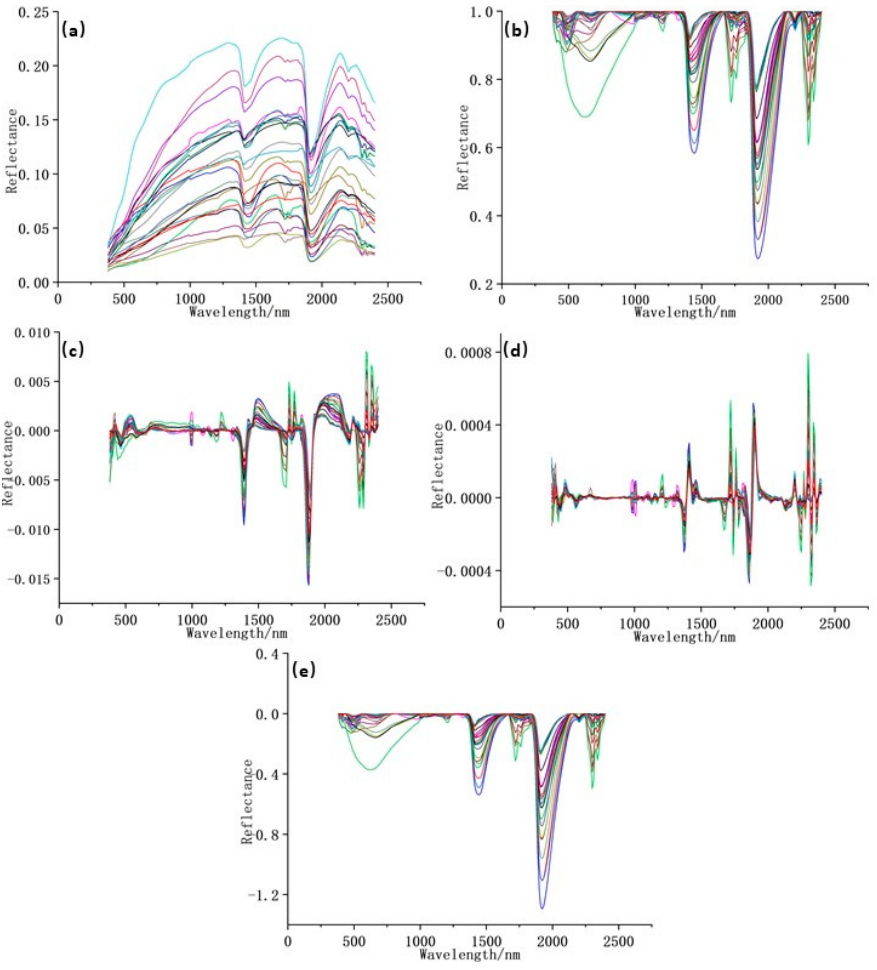
Figure 2. Five spectral forms of samples: ( a ) initial re fl ectance; ( b ) continuum removal of re fl ectance; ( c ) fi rst derivative of re fl ectance; ( d ) second derivative of re fl ectance; ( e ) napierian logarithm of re- fl ectance.